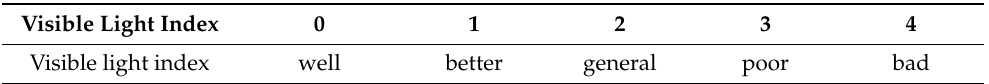
Table 2. Visible light index division. Visible Light Index 0 1 2 3 Visible light index well better general poor